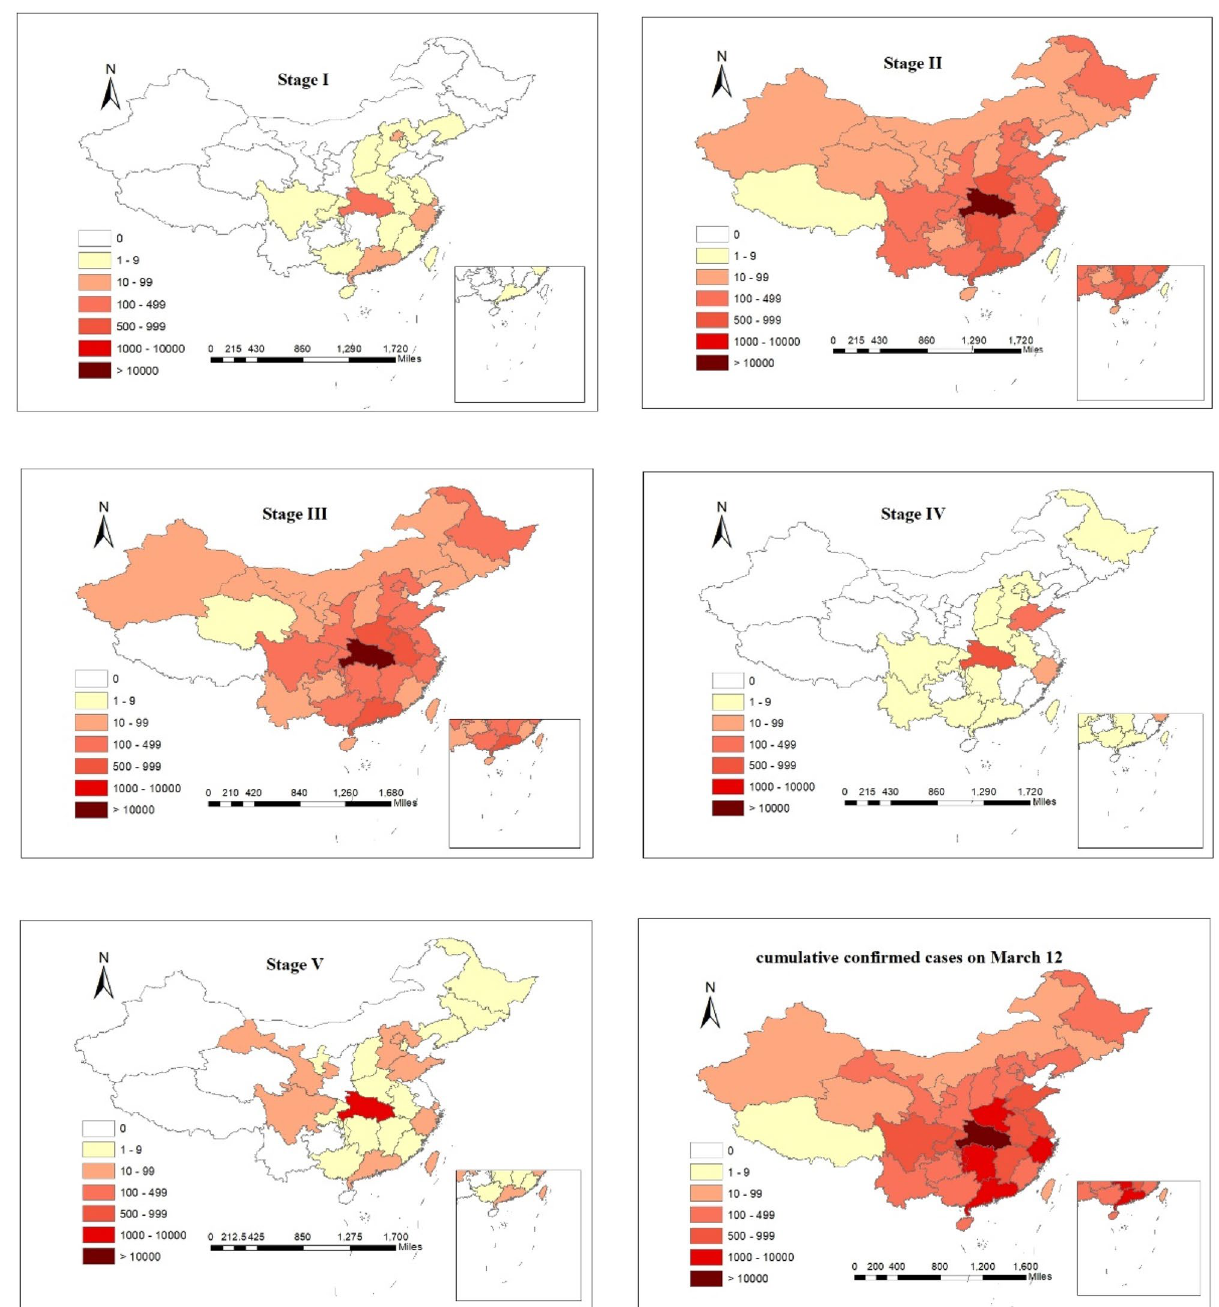
Figure 4. Distribution of newly confirmed cases in China at various stages and cumulative confirmed cases on March